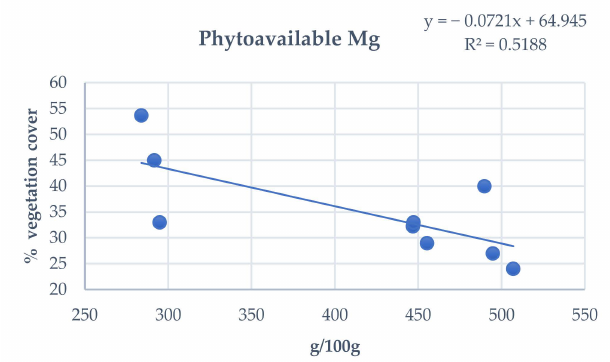
Figure 9. Relationship between available Mg and P. spathulatus scrub